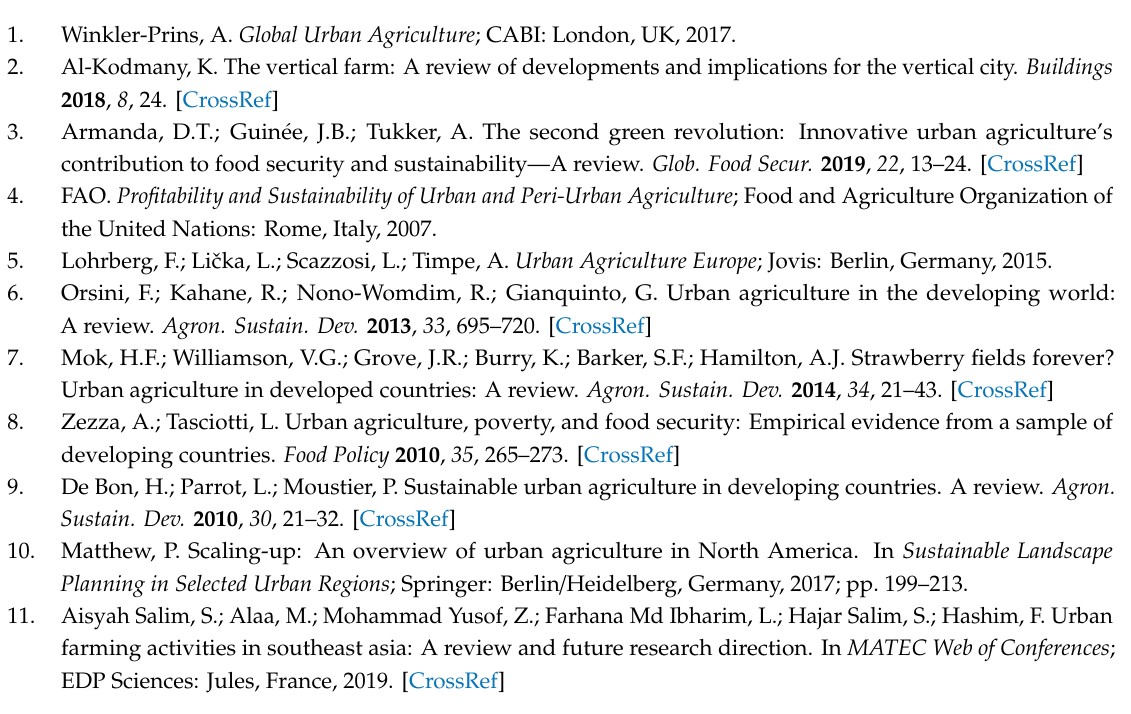
Table S1. Urban farm products and average market prices reported by farmers (in MMK), Table S2: Di ff erent uses of urban farm